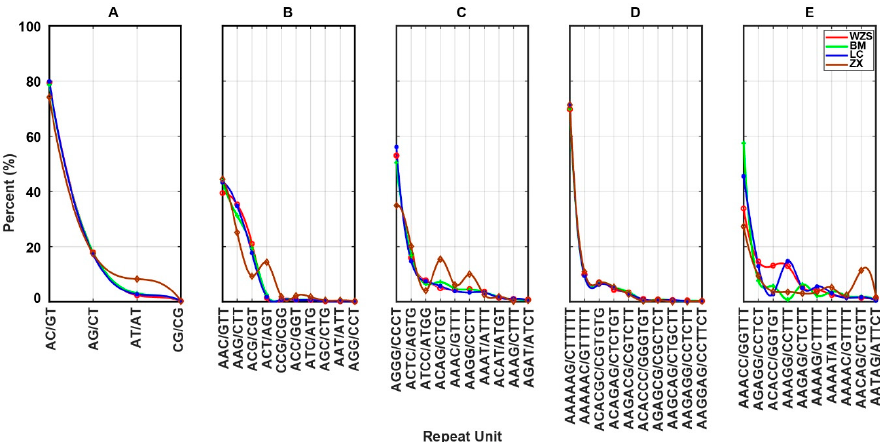
Figure 2. Distribution models of different repeat units among four miniature pig breeds. ( A–E ) Reading from left to right are the distributions of repeat units in Di-SSR, Tri-SSR, Tetra-SSR, Penta-SSR and Hexa-SSR, respectively. The X axis represents types of repeat unit, Y axis represents percentage of repeat units in corresponding total SSRs. The red, green, blue and brown dots connected by lines represent WZS, BM, LC and ZX, respectively.